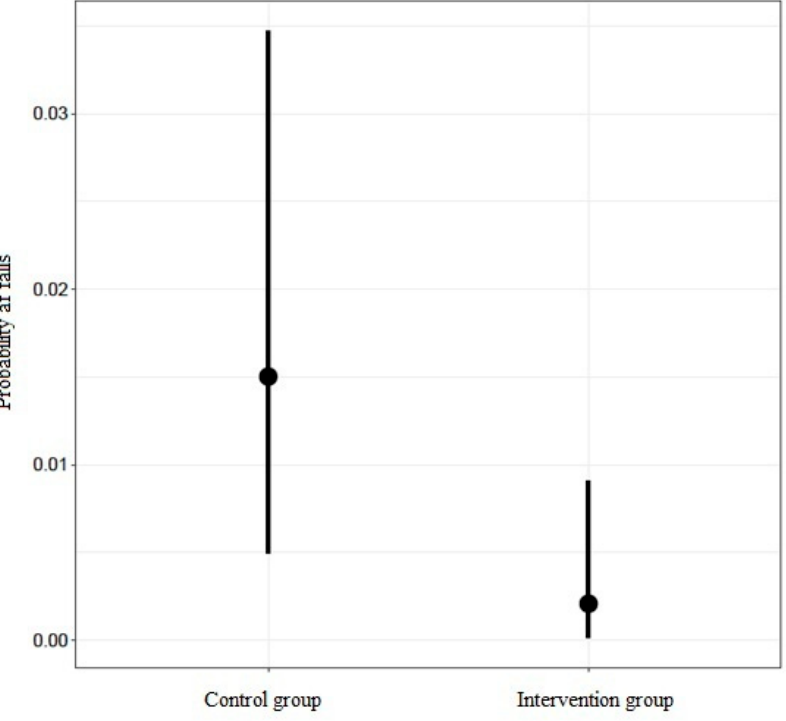
Figure 1. Differences in the probability of fall between the two groups, intervention and control. No significant association was found between the intrinsic risk factors and the incidence of